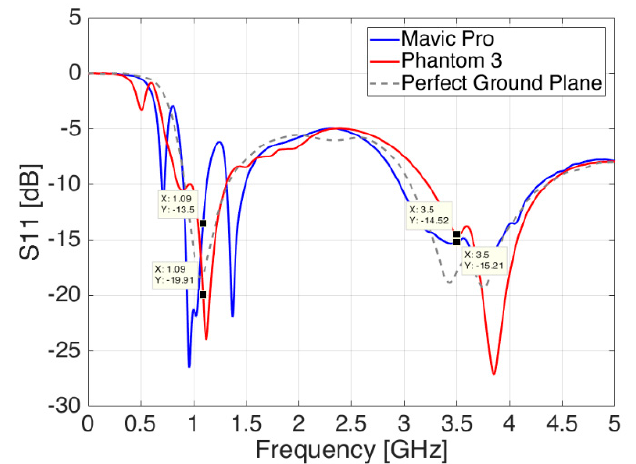
Figure 11. Reflection coefficient S 11 of the blade antenna—ideal ground plane case (dashed grey line) compared to the antenna placement on DJI Phantom 3 (red line) and DJI Mavic Pro (blue line).